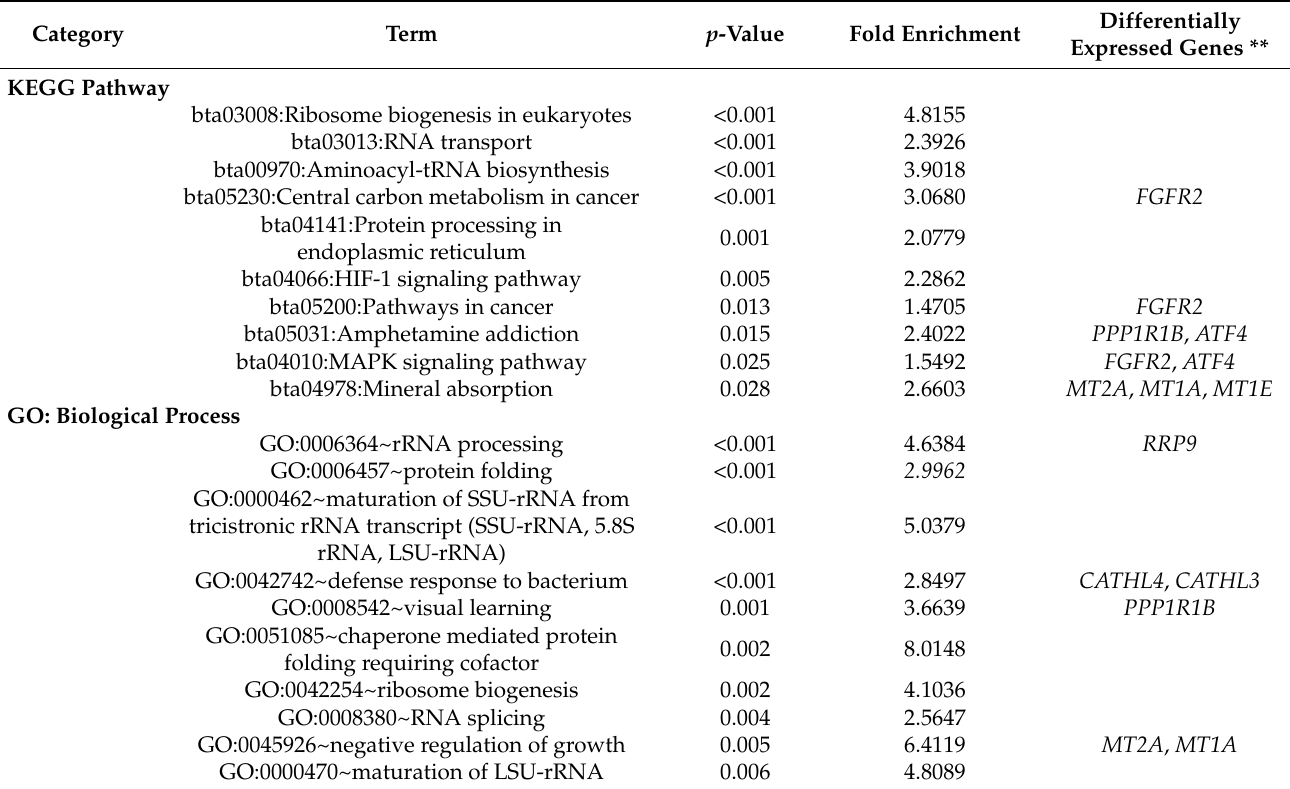
Table 5. Altered fetal liver metabolisms and pathways extracted from upregulated genes